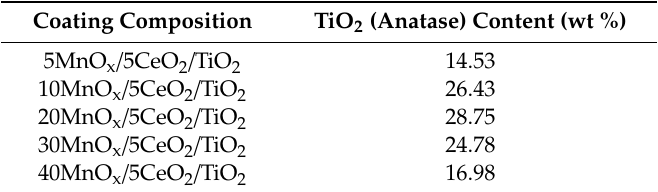
Table 2. The content of anatase in the coating with di ff erent MnO x content.